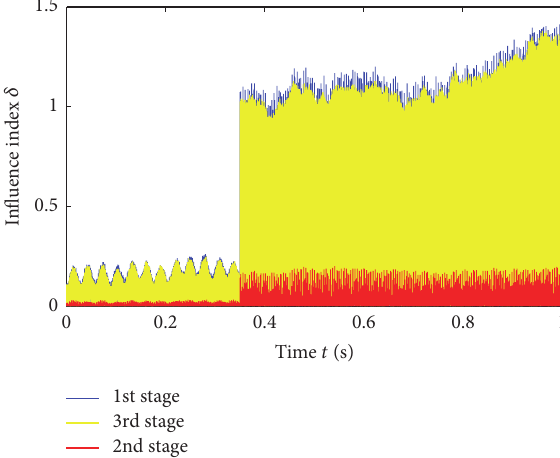
Figure 14: Influence index 𝛿 on different components in the 1st stage.